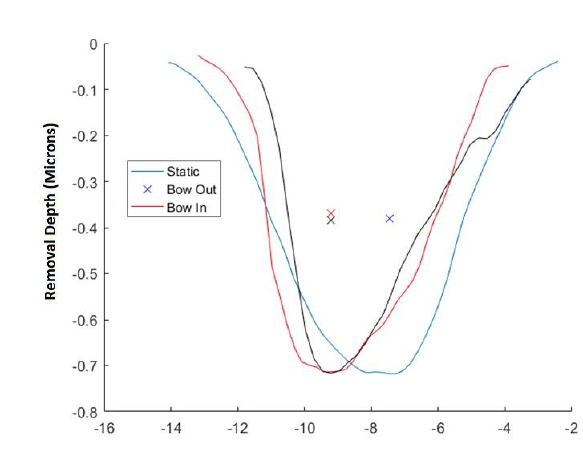
Fig. 1. Dynamic FPs and static FPs showing shape change.